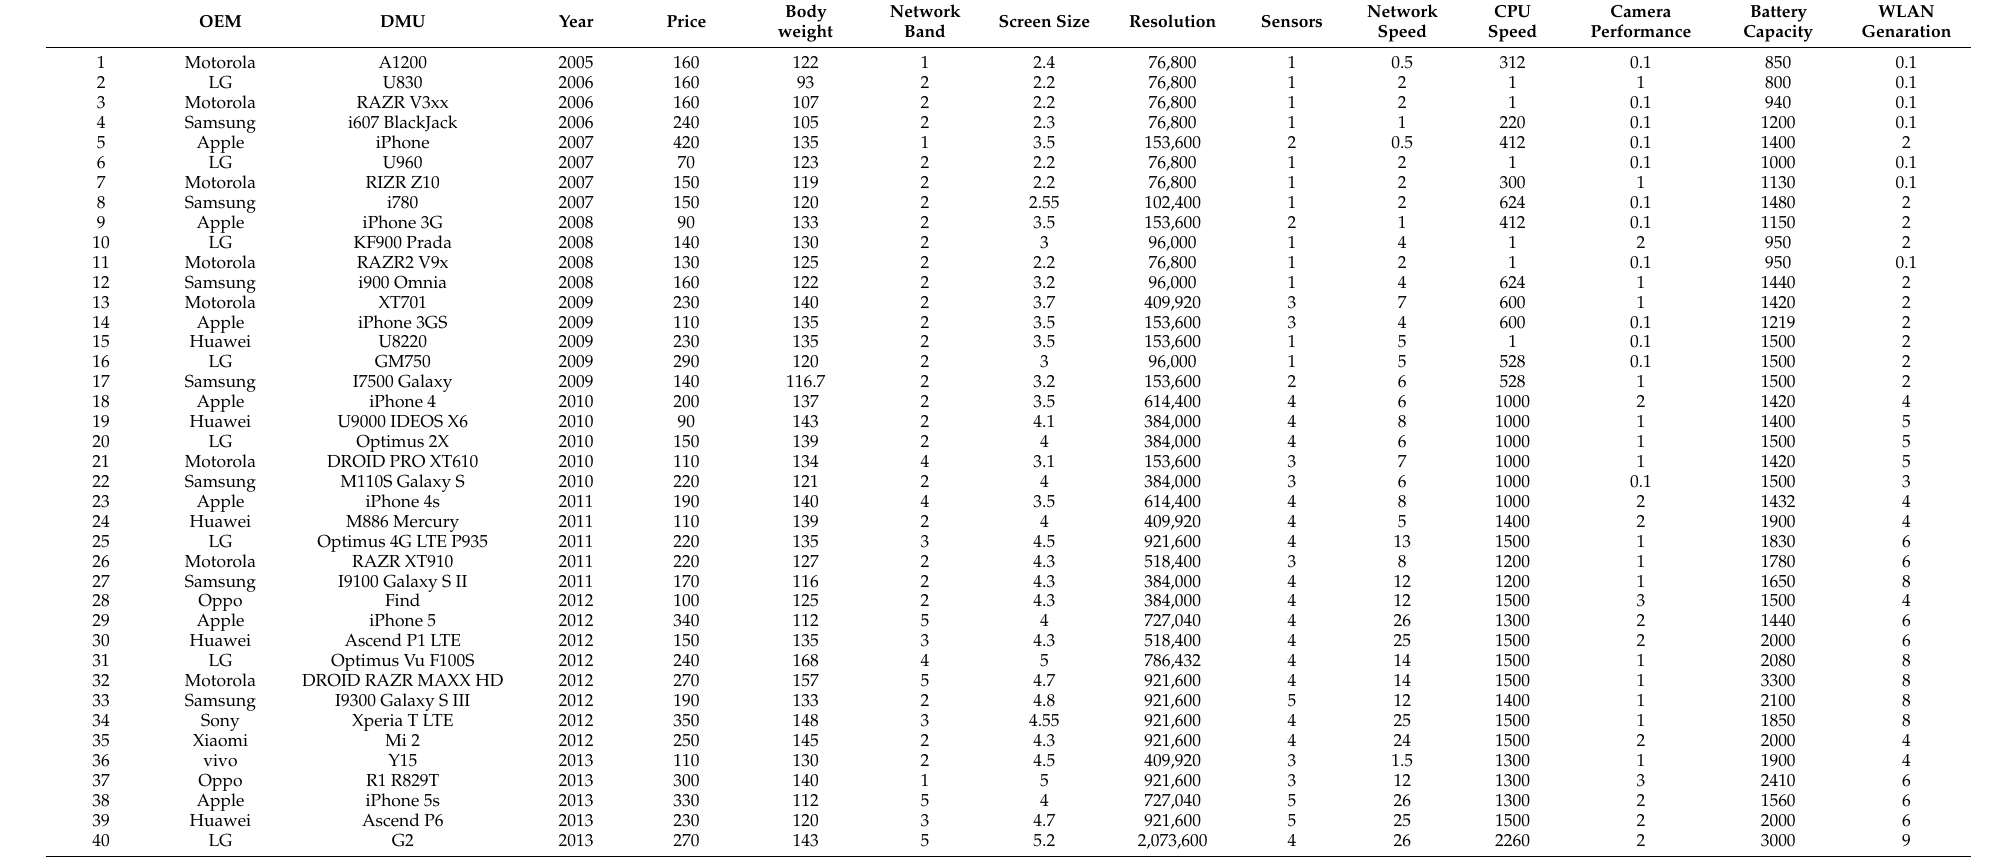
Table 1. Smartphone Dataset from 2005 to